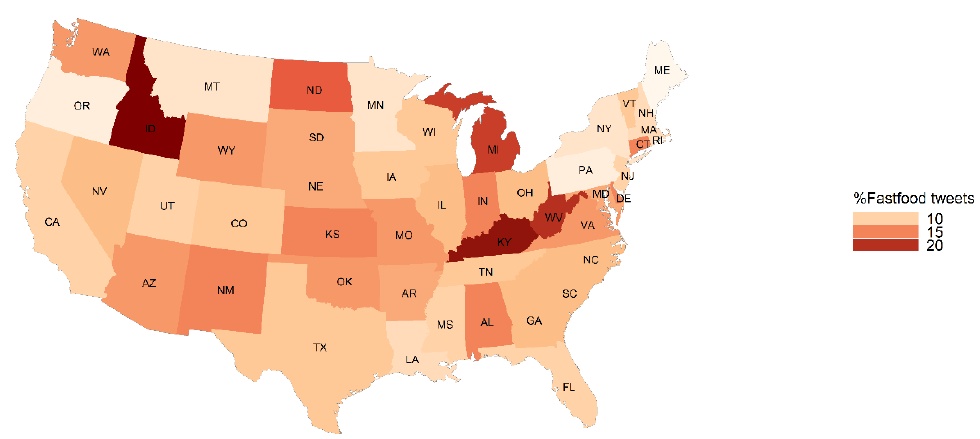
Figure 1. State level percent of food tweets with a fast food mention in the contiguous United States, Twitter 2015–2018.